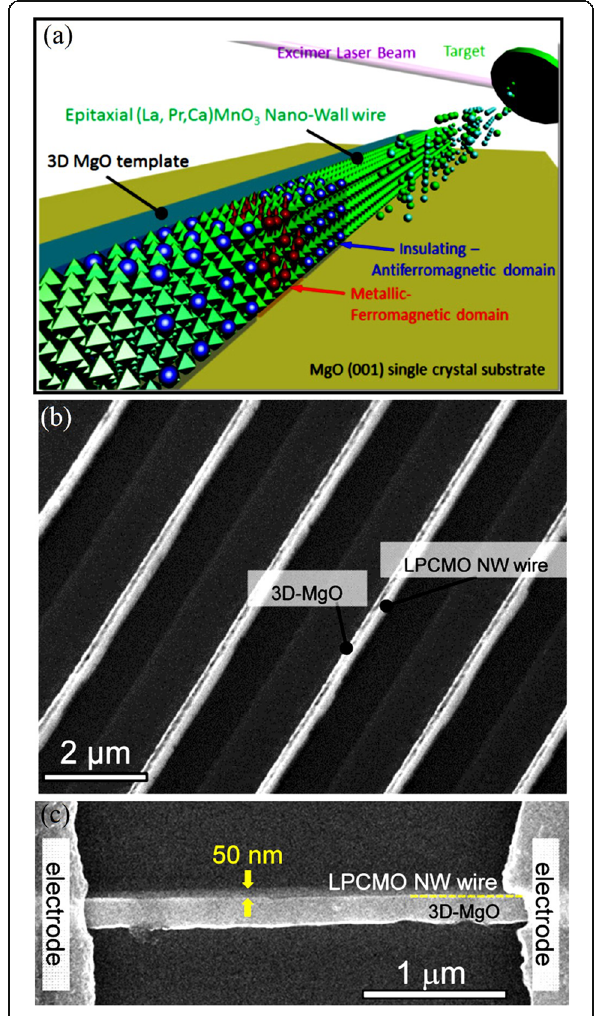
Fig. 16 a Concept of an original nanofabrication technique, 3D nanotemplate PLD, where (La 0.275 Pr 0.35 Ca 0.375 )MnO 3 (LPCMO) is deposited onto the side-surface of 3D MgO using inclined PLD. b SEM image of the LPCMO nanowires with 50 nm width on a MgO (001) single crystal substrate. c Top-view SEM image of an LPCMO nanowire structure bridging electrodes with a 2 μ m gap. Reproduced with permission of